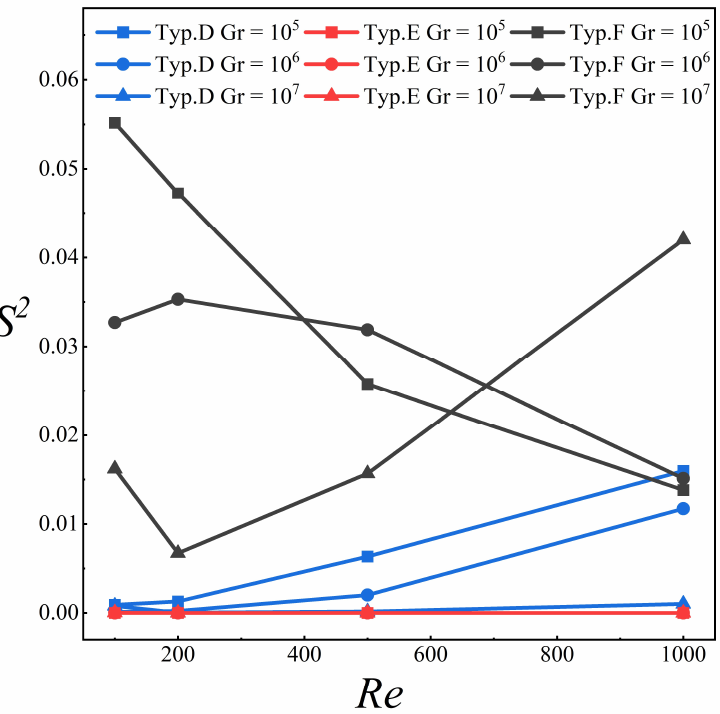
Figure 14. The different heat arrangement (Type D, Type E and Type F) with temperature variance at position